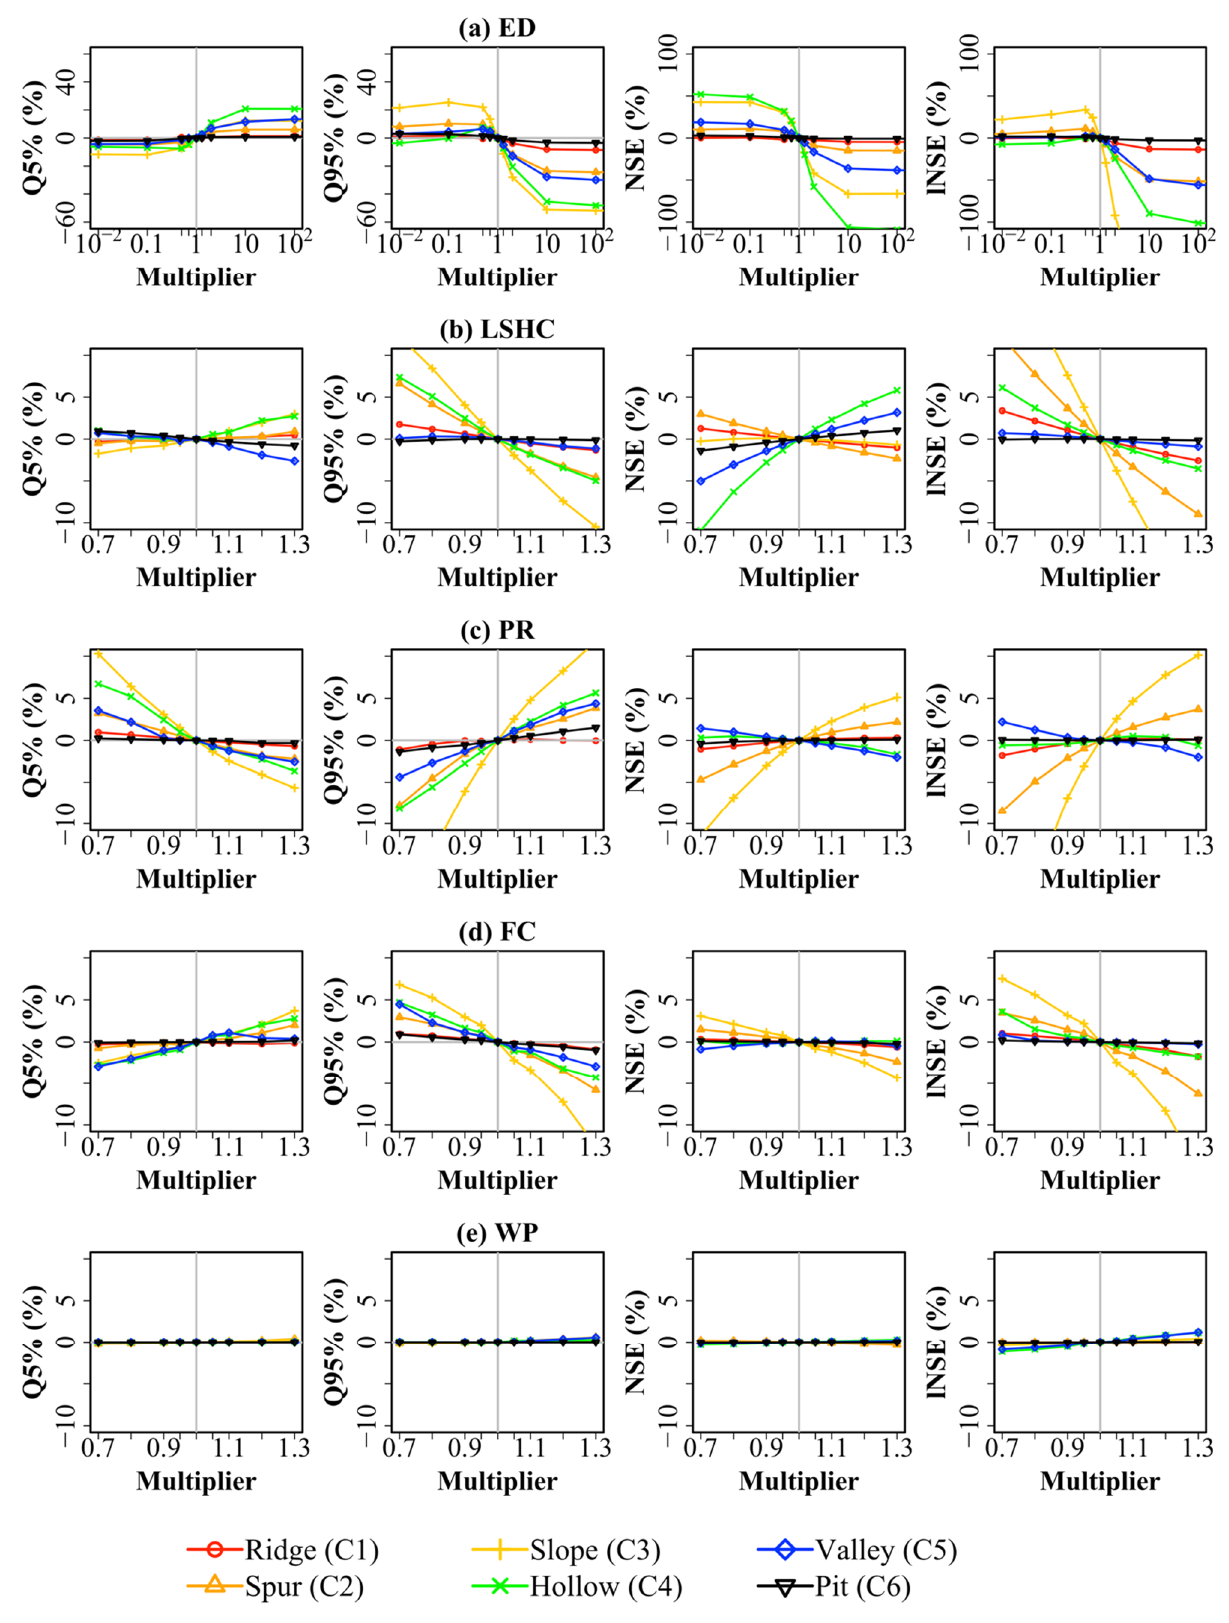
Figure 5. Percentage variation (columns from left to right) of streamflow associated with an exceeding probability of 5% (Q5%) and 95% (Q95%), Nash–Sutcliffe coefficient (NSE), and logarithmic NSE (lNSE) when the ED ( a ), LSHC ( b ), PR ( c ), FC ( d ), and WP ( e ) soil parameters are changed in each Geomorphons feature.